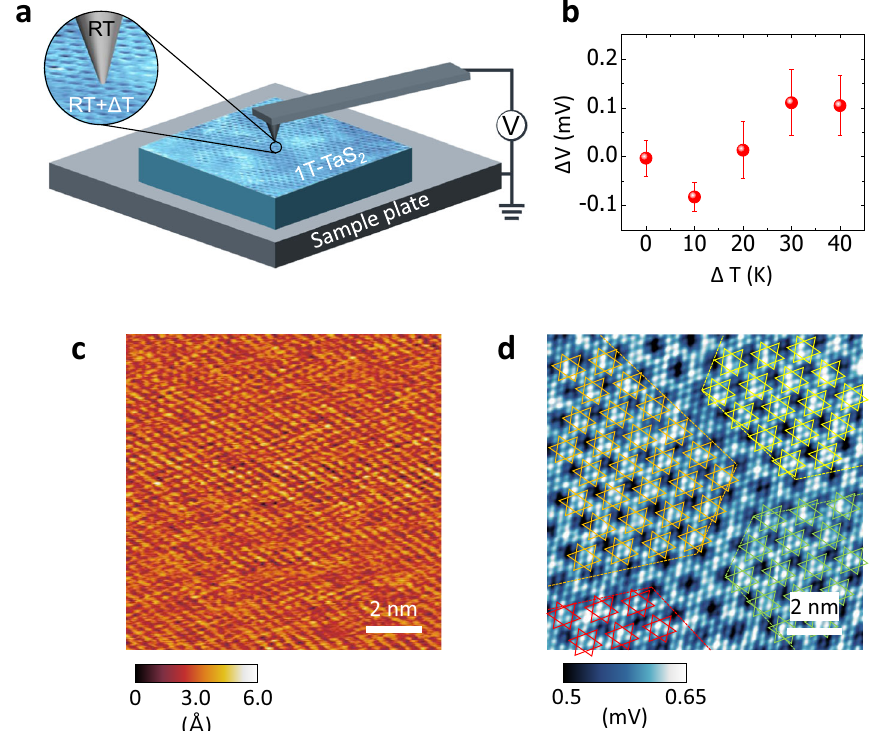
Fig. 1 | SThEM of the nearly commensurate CDW phase in 1T-TaS 2 . a Schematic of the SThEM with 1T-TaS 2 . The temperature of the sample can be controlled from T=78Kto450K,andthetipiskeptatroomtemperatureintheSThEM. b Averaged thermopower ( Δ V)as a function of temperature difference ( Δ T). The Δ T is de fi ned by T sample -T tip . Error bars represent standard deviations. c , d Topography c and